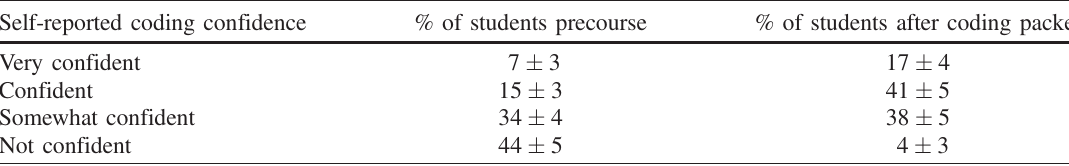
TABLE III. Student self-reported “ coding confidence ” before beginning the course and after completing the coding packet assignment in week 4 of the course. The uncertainty was calculated using the 95% binomial confidence